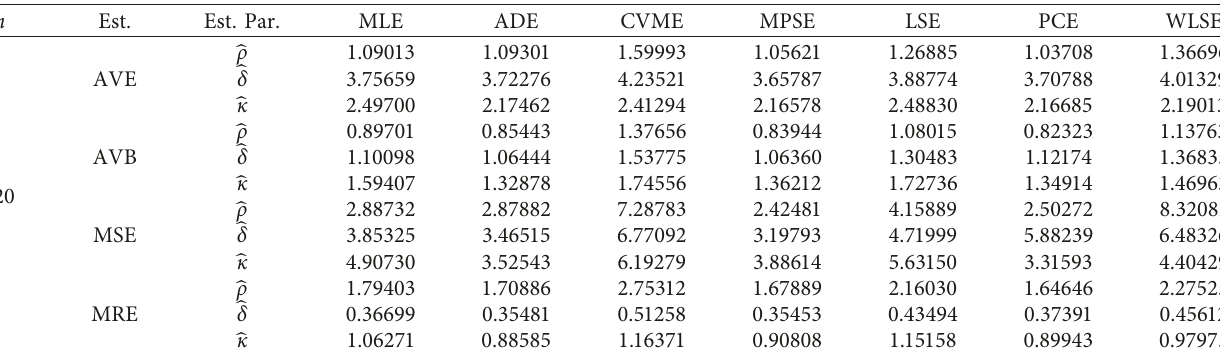
Table 6: Simulation results of the AVE, AVB, MSE, and MRE of BXLE distribution for ( ρ � 0 . 5 , δ � 3 , κ � 1 . 5 ) . n